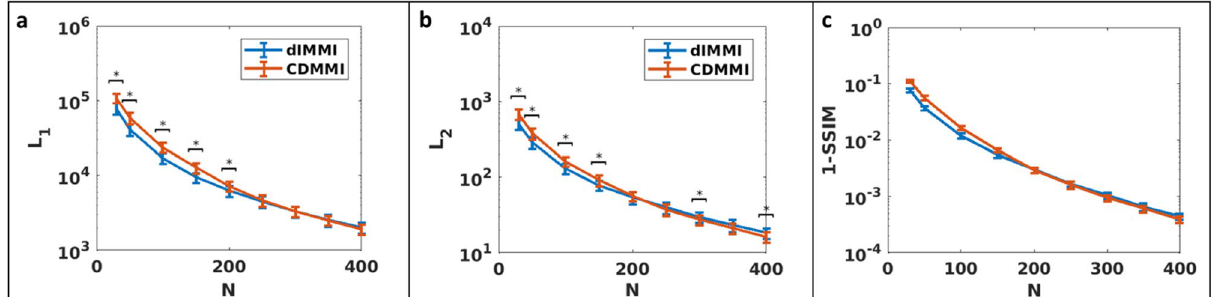
Figure 3. Comparison of dIMMI and CDMMI models. The dIMMI model has statistically superior performance in accurately modelling the photoacoustic imaging process for low image resolutions ( a , b ) under both the L 1 and L 2 norms. At high resolutions, CDMMI trended towards superior performance over dIMMI, though does not consistently achieve statistical separation. ( c ) Both dIMMI and CDMMI have improved SSIM scores as a function of pixel resolution; CDMMI achieves slightly better performance at high resolutions. Figure created using a combination of MATLAB and Microsoft PowerPoint.